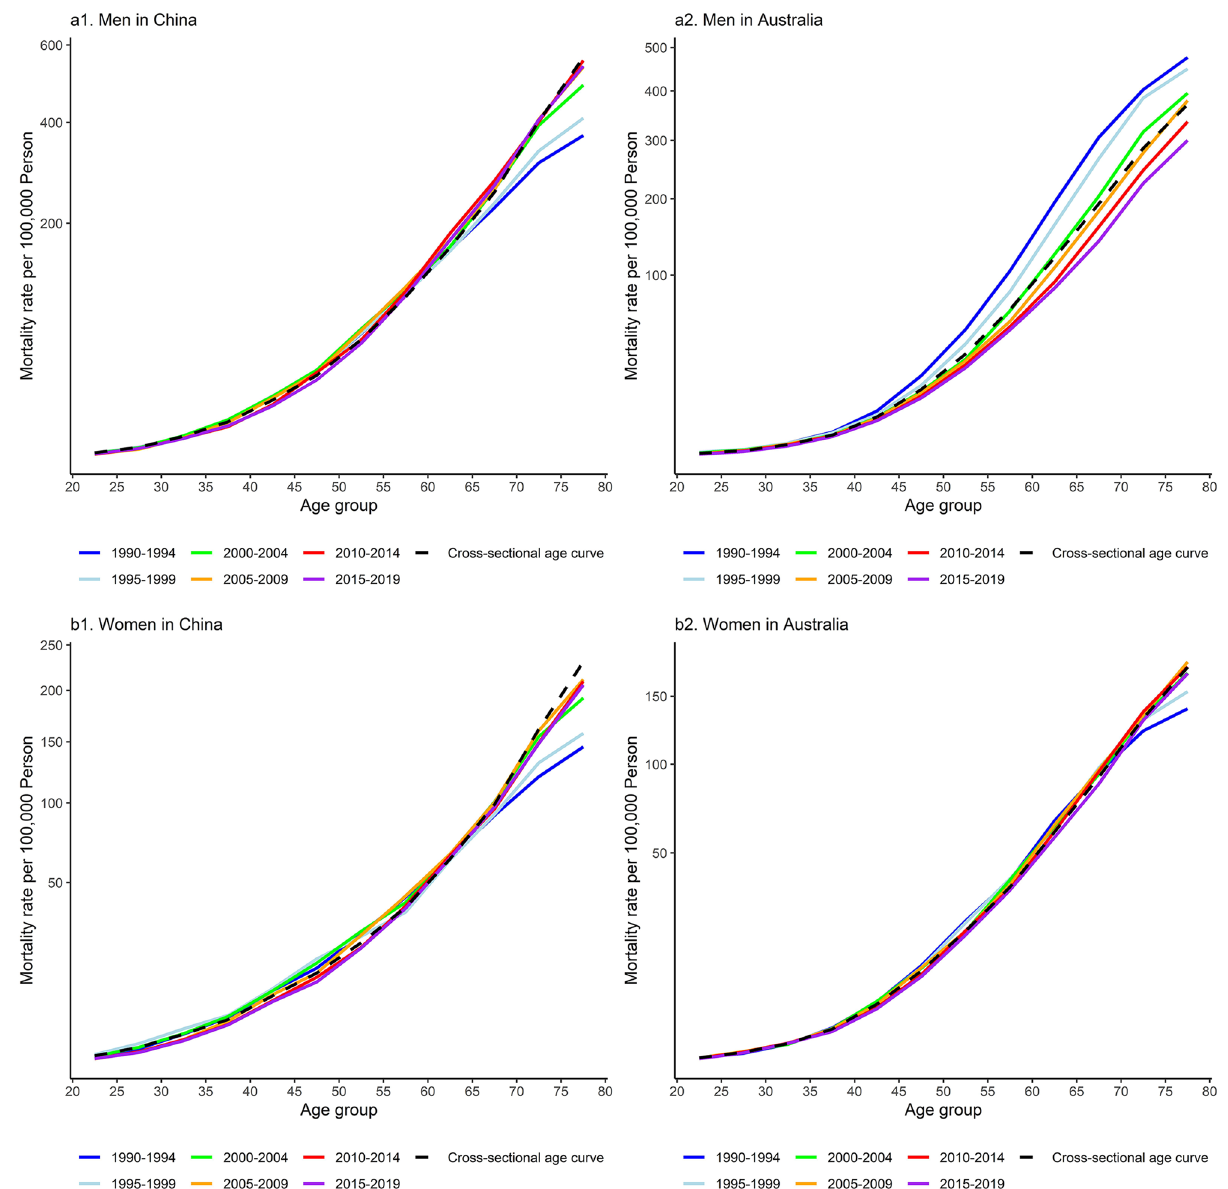
Figure 2. Age-specific mortality rates of lung cancer by period and sex in China and Australia, 1990 to 2019. The study period was organized into 5-year periods from 1990–1994, 1995–1999, 2000–2004, 2005–2009, 2010– 2014, to 2015–2019. ( a1,b1 ) Reveal that lung cancer mortality rate increased among men and women aged 65 or older in China over the study period (P < 0.001). ( a2 ) Shows that in Australian men, lung cancer mortality rate decreased over the study period in all age groups (P < 0.001). ( b2 ) Shows that lung cancer mortality rate increased among Australian women aged 70 or older (P < 0.001). Cross-sectional age curves present the expected age-specific rates in reference period, i.e., 2000 to 2004, after adjusting for cohort